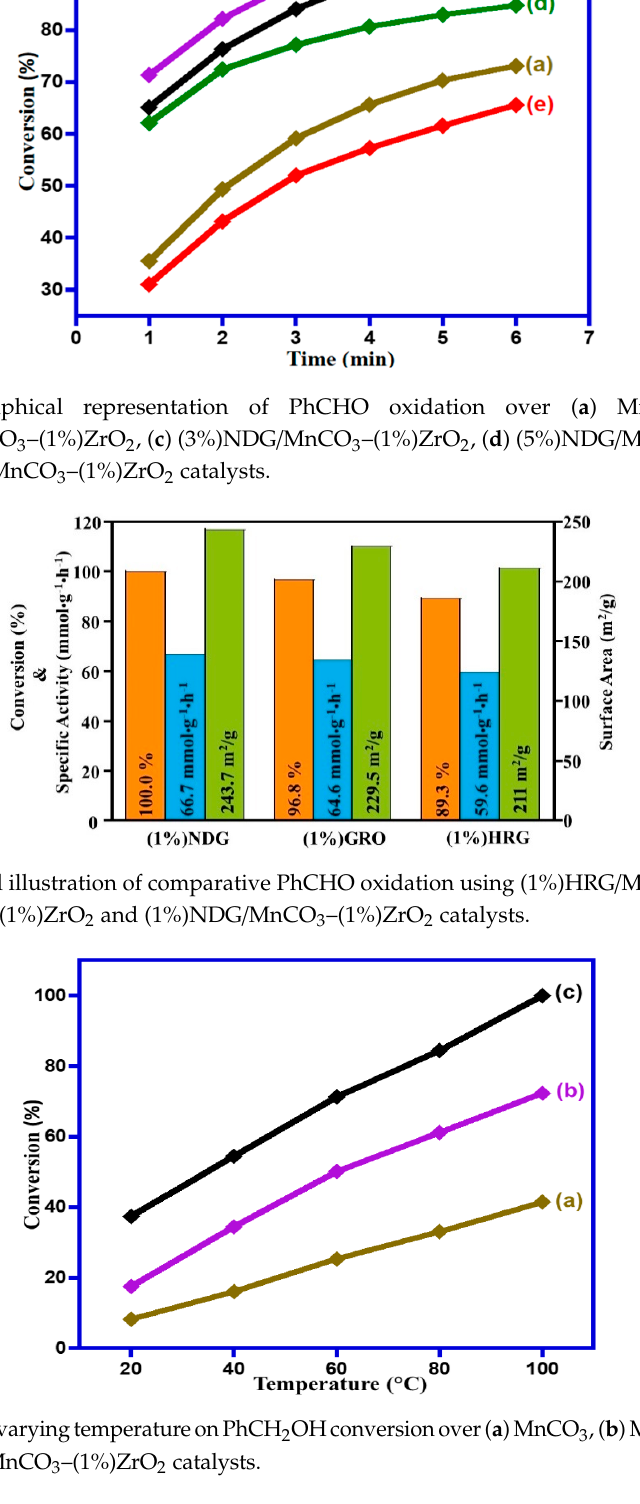
Figure 10. Impact of varying catalyst dosage on the PhCH 2 OH conversion over ( a ) MnCO 3 , ( b ) MnCO 3 –(1%)ZrO 2 and ( c ) (1%)NDG/MnCO 3 –(1%)ZrO 2 catalysts.